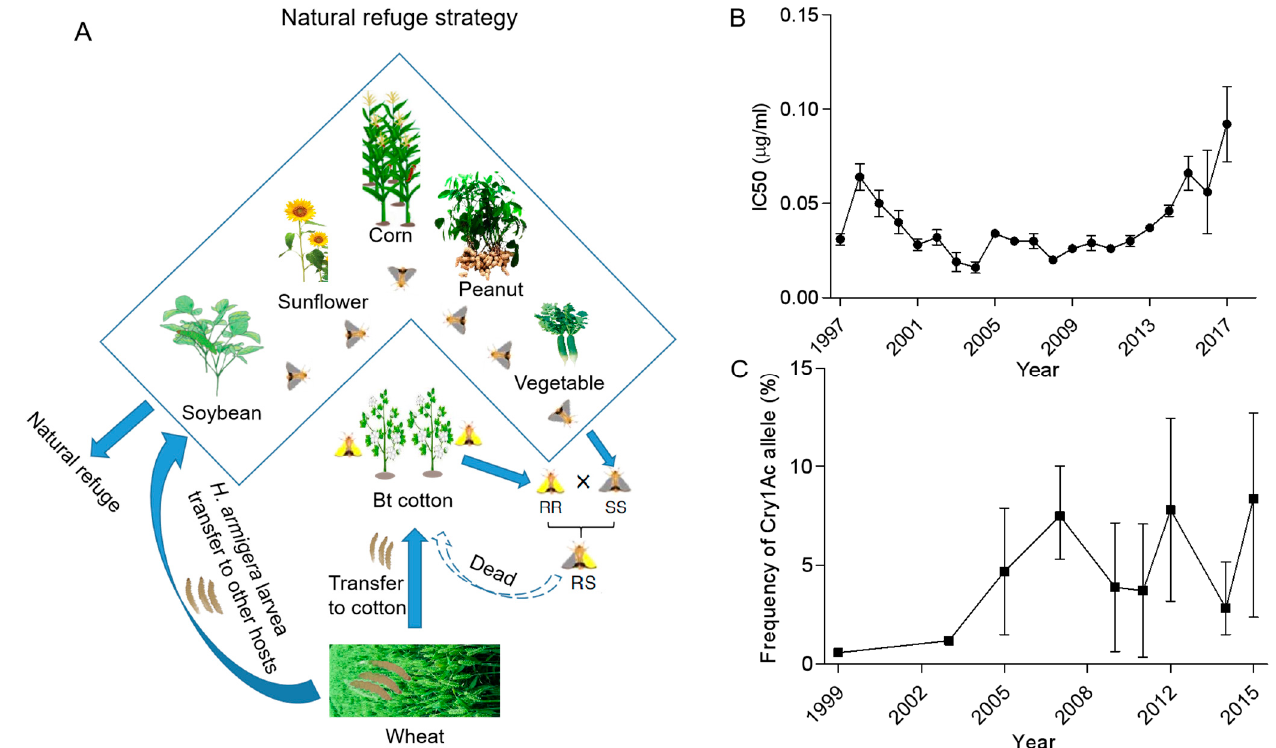
Figure 1. Natural refuge strategy ( A ) and field monitoring of Helicoverpa armigera regarding Cry1Ac resistance IC50s and alleles ( B , C ) in China. The IC50 is the concentration of the Cry1Ac protein that inhibits larval development by 50%, and the error bars stand for the 95% fiducial limits. The frequency of alleles in field Helicoverpa armigera was obtained through an F1 screen from the previous work. Bioassay data of IC50 and frequency of alleles in the figures are from Zhang et al. [24,56,57].